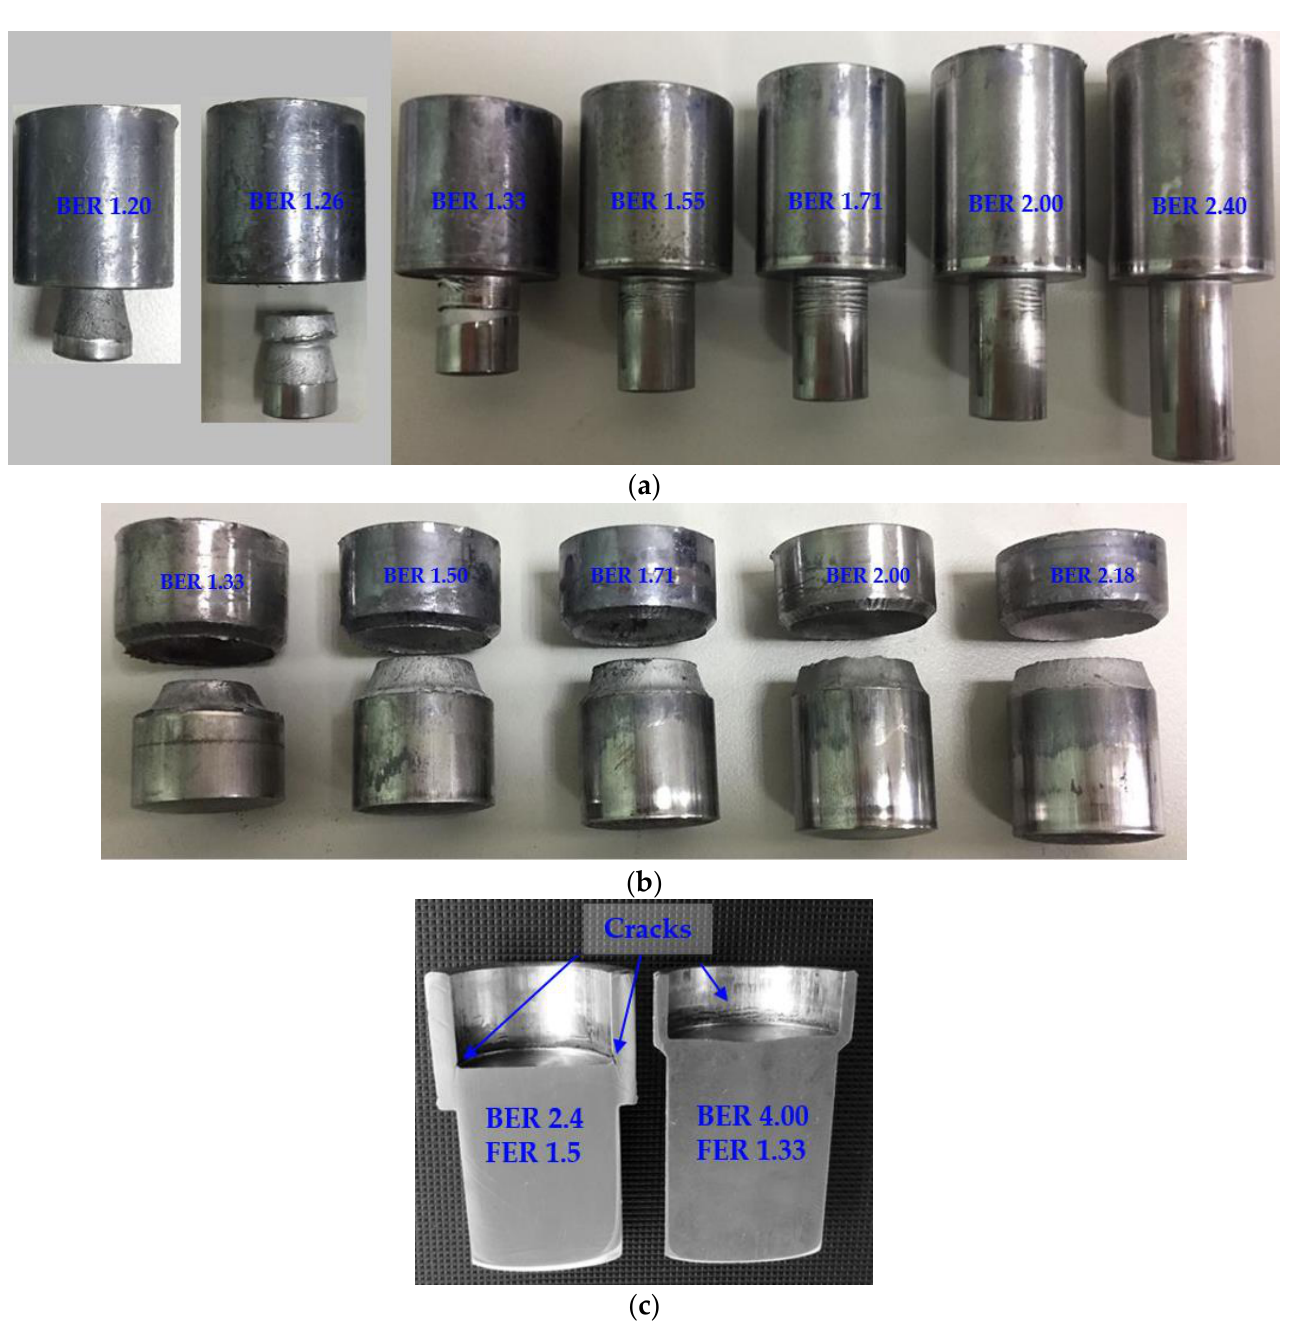
Figure 5. Photos of representative forming defects of various combinations of FER and BER: ( a ) Forward piercing and surface-crack defects for FER fixed at 4, ( b ) backward piercing defects for FER fixed at 1.33, ( c ) backward defects for FER 1.5-BER 2.4 and FER 1.33-BER 4.